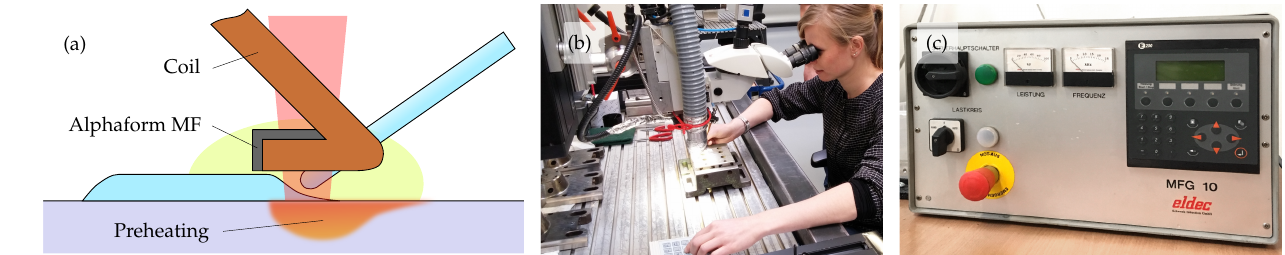
Figure 3. ( a ) Schematic view of the setup. ( b ) Experimental setup of the welding table with 3-axis positioning unit. ( c ) Induction generator used for the experiments.